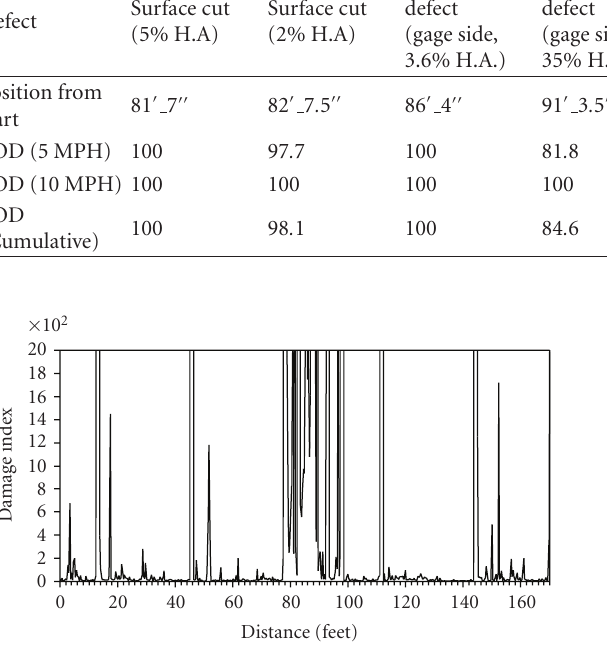
Figure 11: Field testing damage index as a function of the inspection distance. Large peaks denotes the presence of joints, smaller peaks denote the presence of